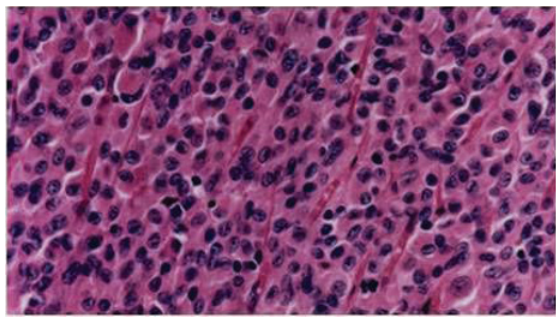
Figure 4. An epithelioid pattern with increased mitotic activity is shown (H & E, original